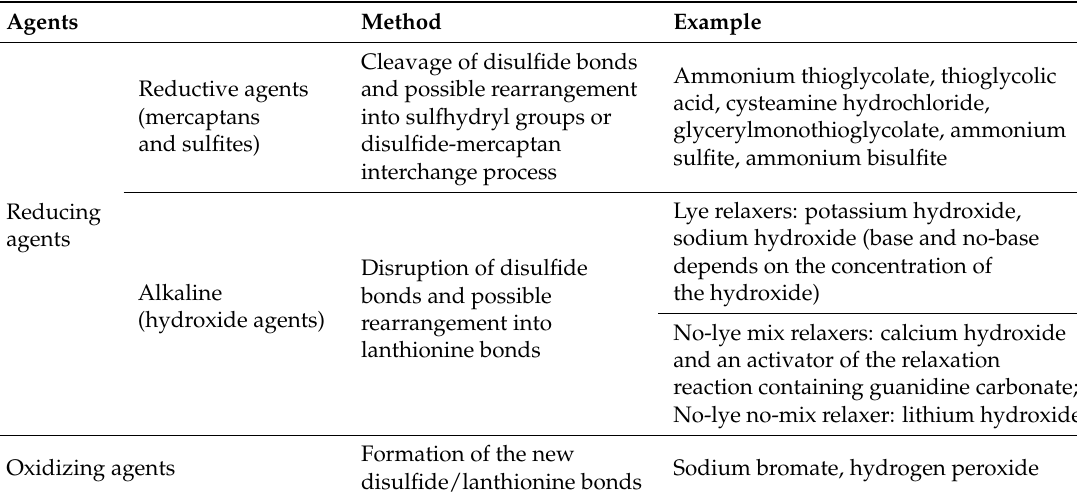
Table 3. Hair straightening agents